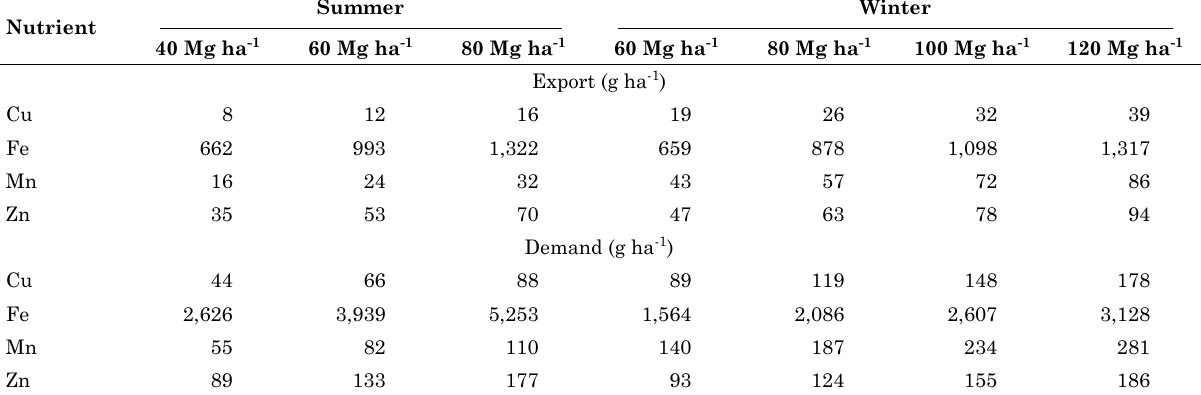
table 6. export of and demand for cationic micronutrients generated by ferticalc carrot as a function of the intended yield of roots and the growing season (winter or summer) Summer Winter Nutrient